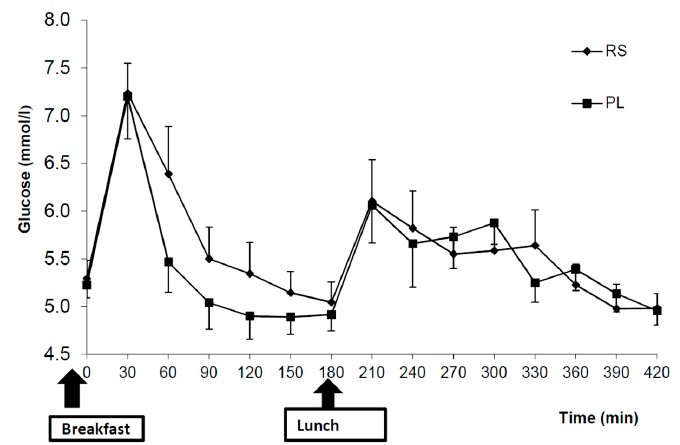
Figure 2. Postprandial plasma glucose concentrations after the consumption of 48 g of resistant starch (RS) compared with a placebo (PL). The values represent means ± SEM ( n = 10). Comparisons were made with repeated measures ANOVA.